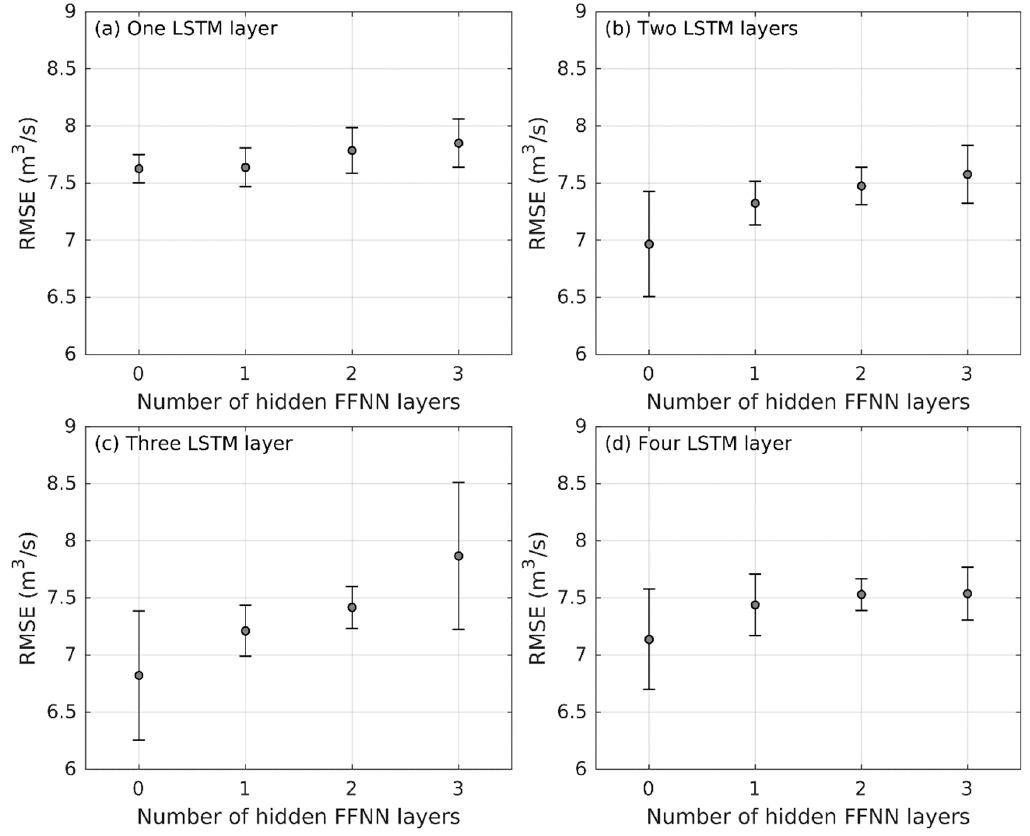
Figure 8. RMSE of a Maipo en el Manzano validation subset as a function of the number of LSTM and FFNN hidden layers for the DL model, ( a ) results for one LSTM layer, ( b ) results for two layers of LSTM, ( c ) results for three layers of LSTM, ( d ) results for four layers of LSTM.